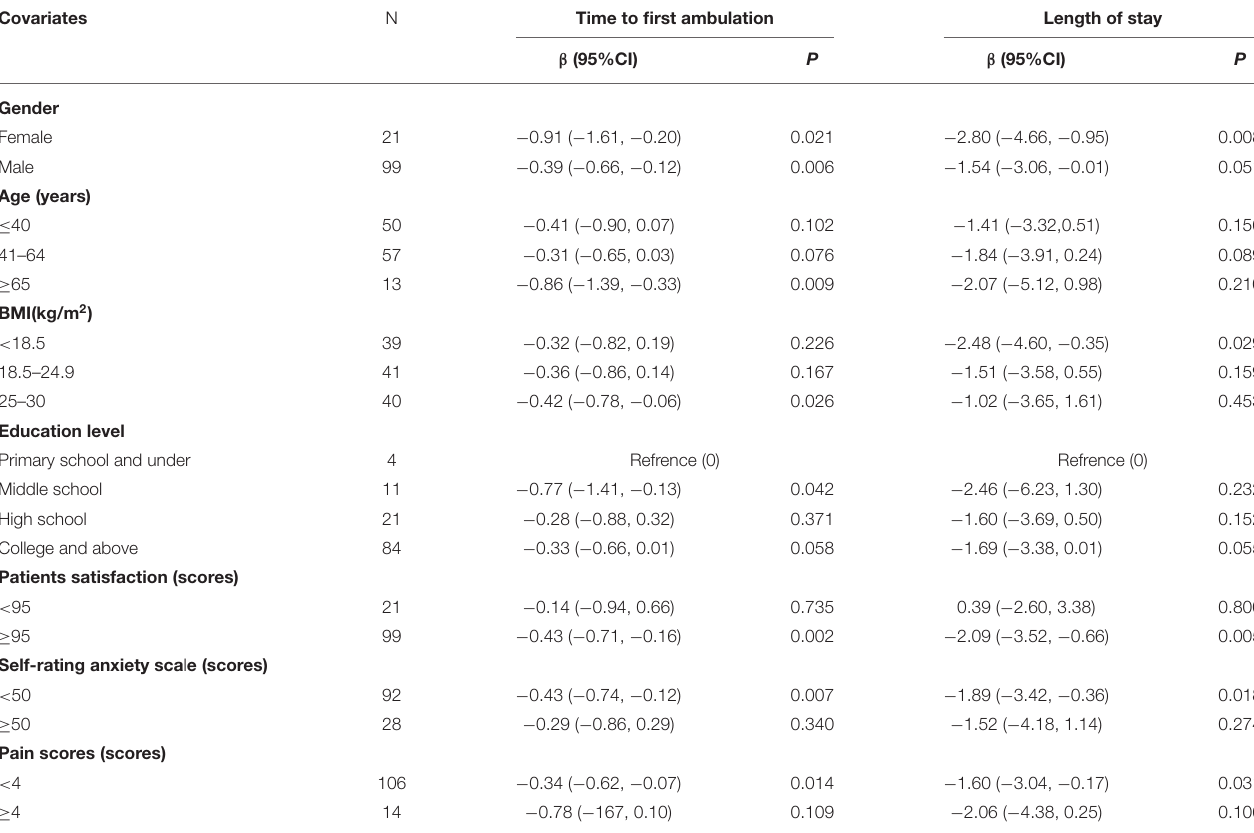
TABLE 2 | Effect size of viewed take-home video on the time to first ambulation (h) and length of stay (h) in prespecified and exploratory subgroups in each subgroup. Covariates